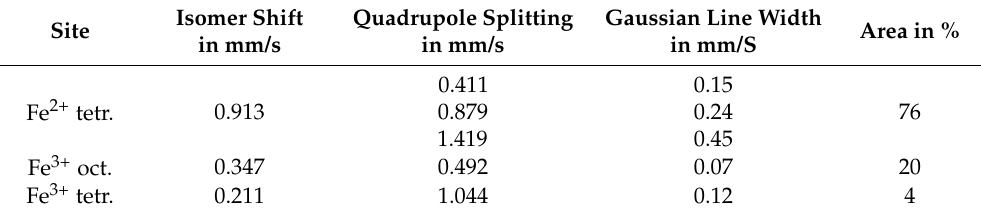
Table 2. 57 Fe Mössbauer parameters of chromite sample.